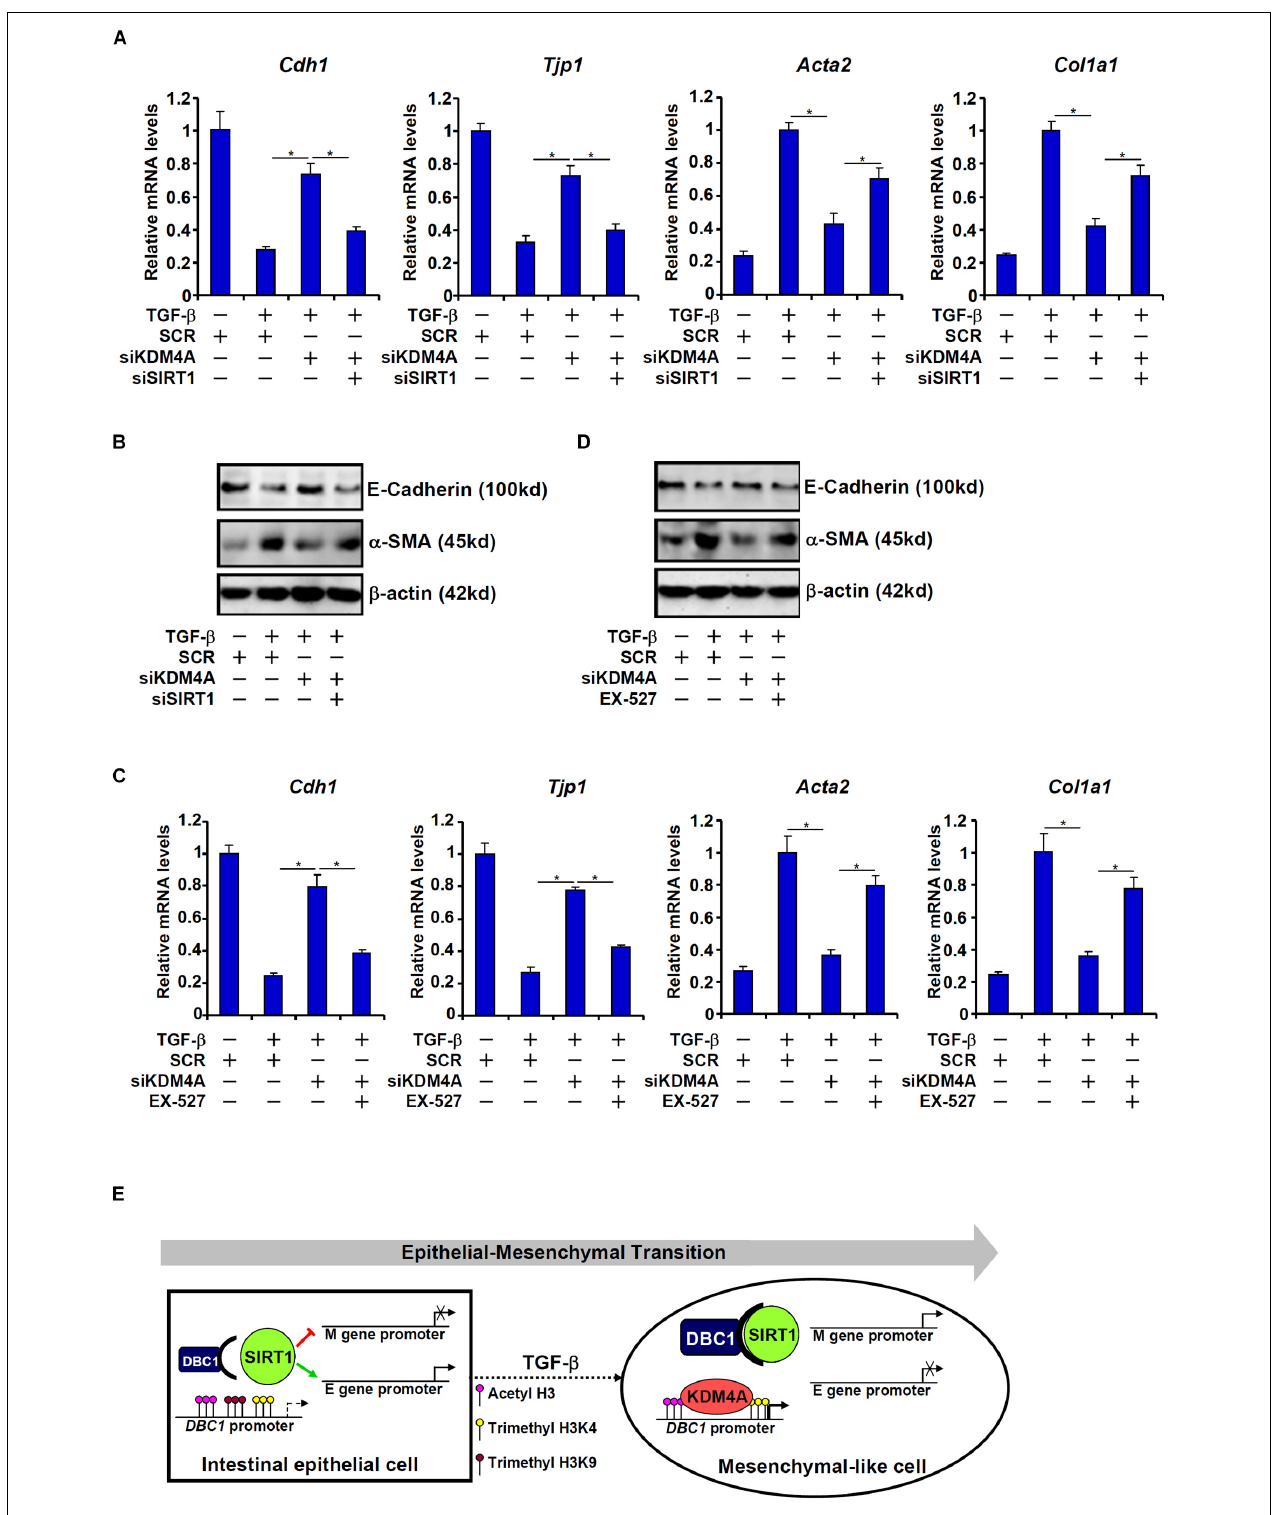
FIGURE 6 | KDM4A silencing or inhibition attenuates TGF- β induced EMT in a SIRT1-dependent manner. (A,B) IEC-6 cells were transfected with indicated siRNAs followed by treatment with TGF- β (2 ng/ml) for 48 h. Gene expression levels were examined by qPCR and Western. (C,D) IEC-6 cells were transfected with indicated siRNAs followed by treatment with TGF- β (2 ng/ml) in the presence or absence of EX527 (10 µ M) for 48 h. Gene expression levels were examined by qPCR and Western. All experiments were performed in triplicate wells and repeated three times. One representative experiment is shown. (E) A schematic model.